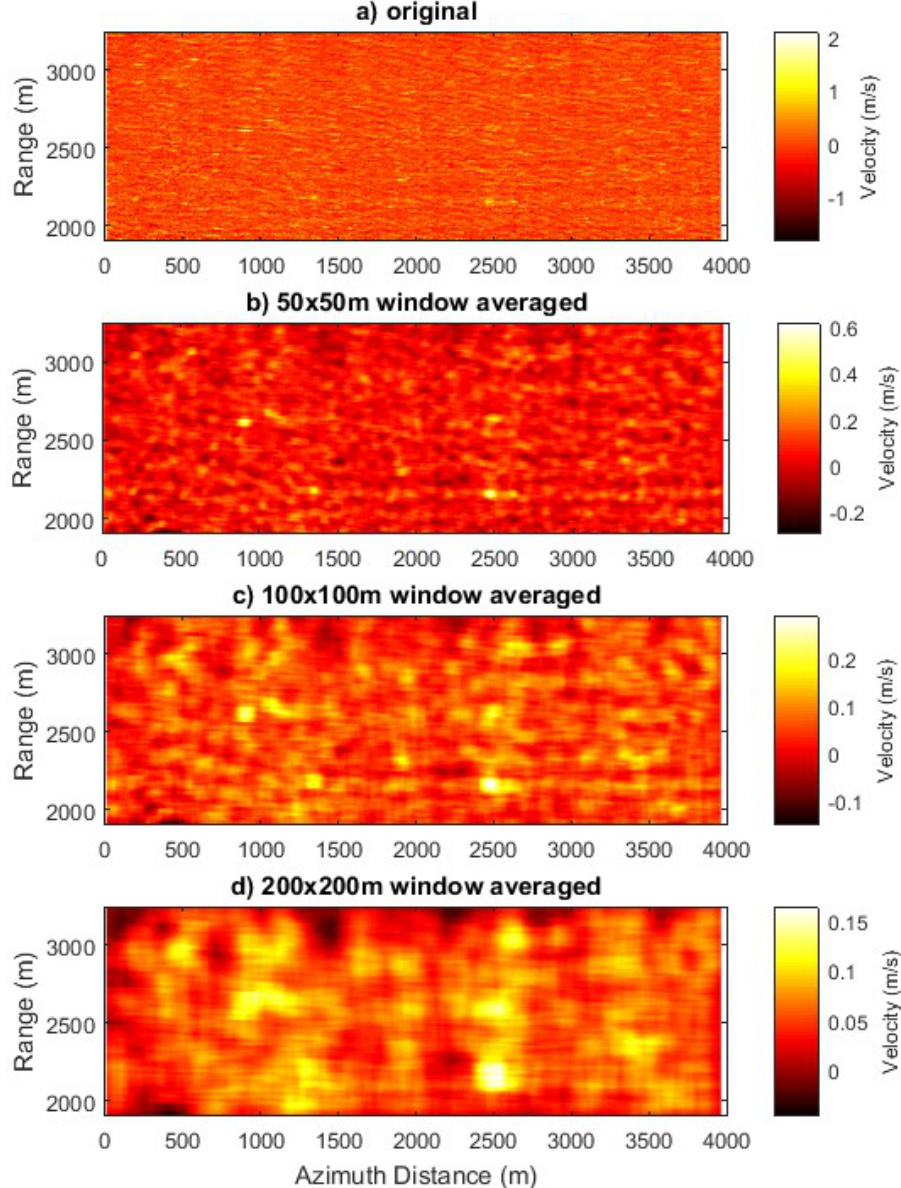
Figure 16. The figure shows original MSAR interferogram ( a ), and its smoothing as it is subjected to square window filtering of increasing size ( b ) 50 × 50, ( c ) 100 × 100, and ( d ) 200 × 200 m. Note, the color corresponds to across-track (i.e., range direction) velocity vector component, whereas the aircraft travels in the azimuthal direction.